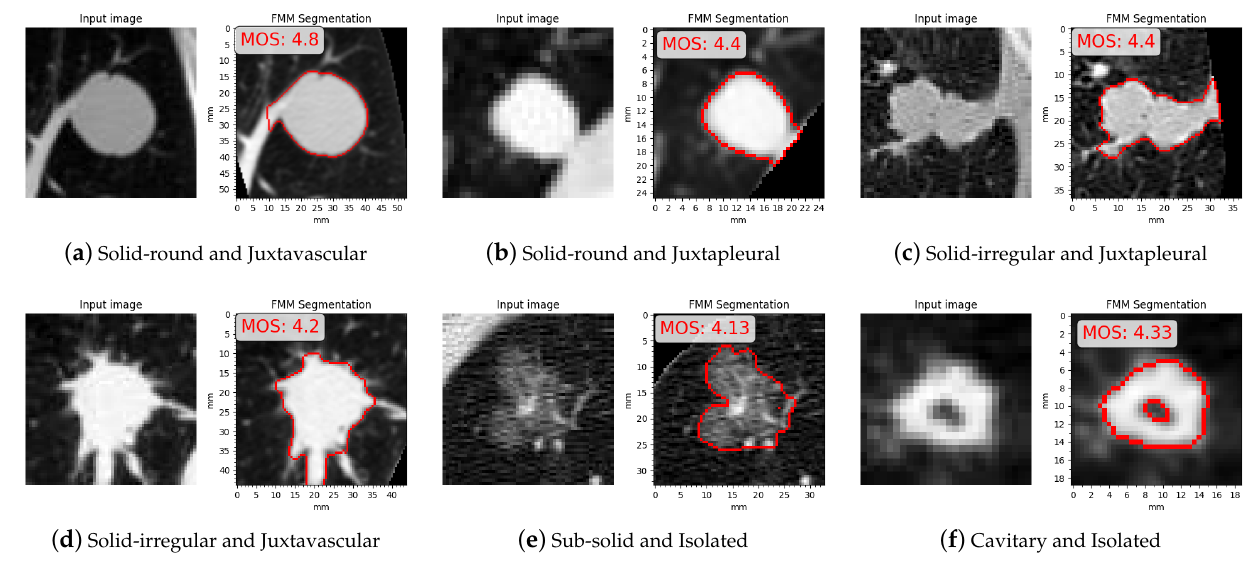
Figure 23. Examples with high mean opinion scores (MOS).